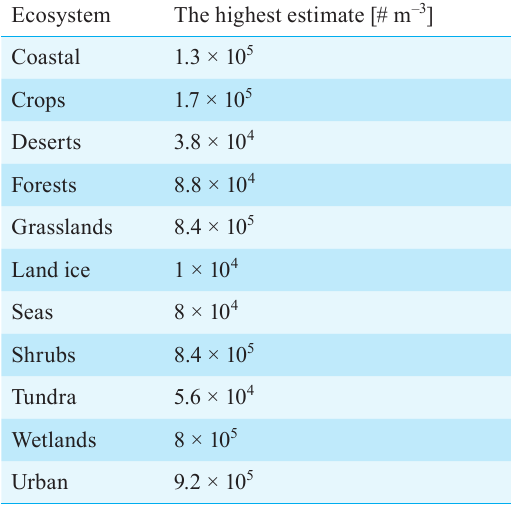
Table 1 Total bacterial concentrations in near-surface air of various